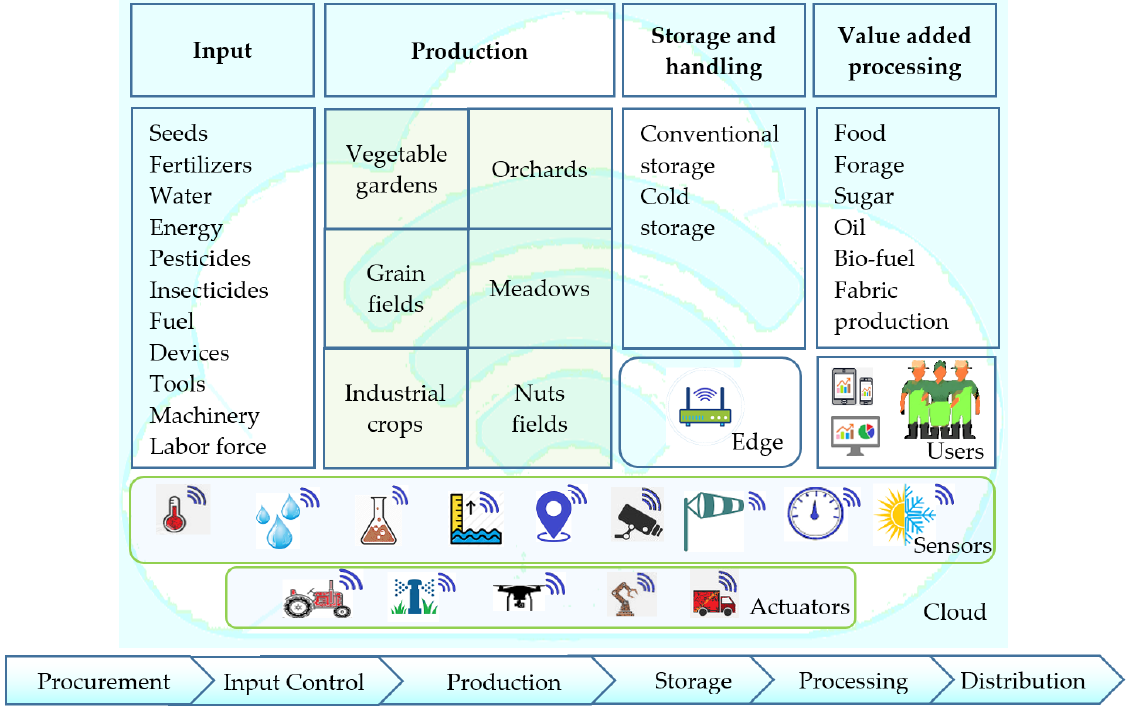
Figure 1. IoT in the agricultural supply chain.